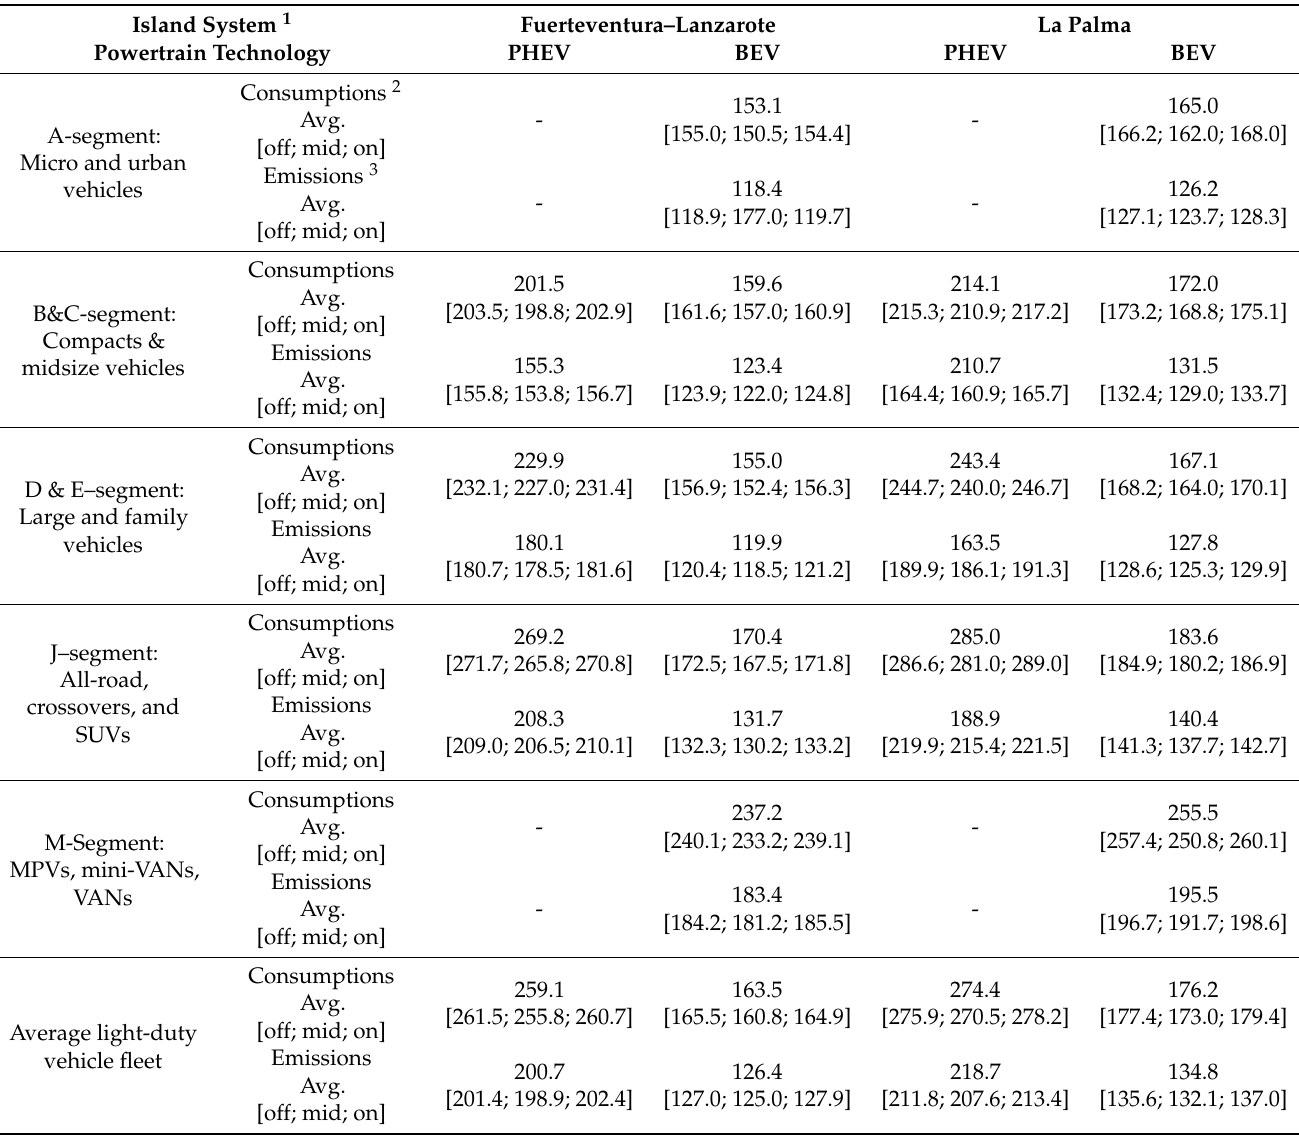
Table 7. The WtW results for PEVs on midsize systems (Fuerteventura–Lanzarote and La Palma in